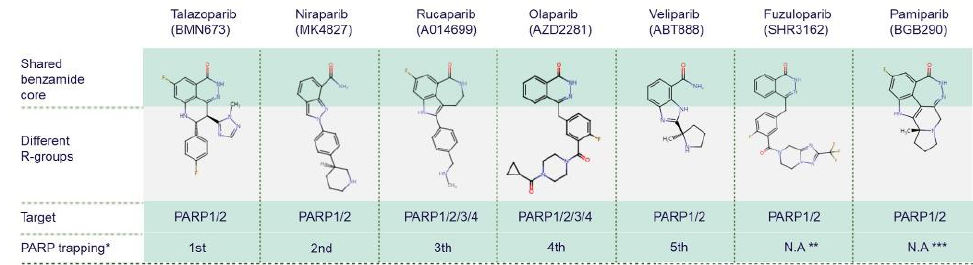
Figure 3. Chemical structures of clinically used PARP inhibitors. The chemical structures of PARP inhibitors (PARPis) are from ChEMBL database (www.ebi.ac.uk/chembl, accessed on 15 June 2022). * PARPis are listed by PARP trapping potency from highest to lowest [80]. ** There is no currently available data (N.A) for fuzuloparib PARP trapping potency. *** There is no currently available data for pamiparib trapping potency relative to other PARPis.